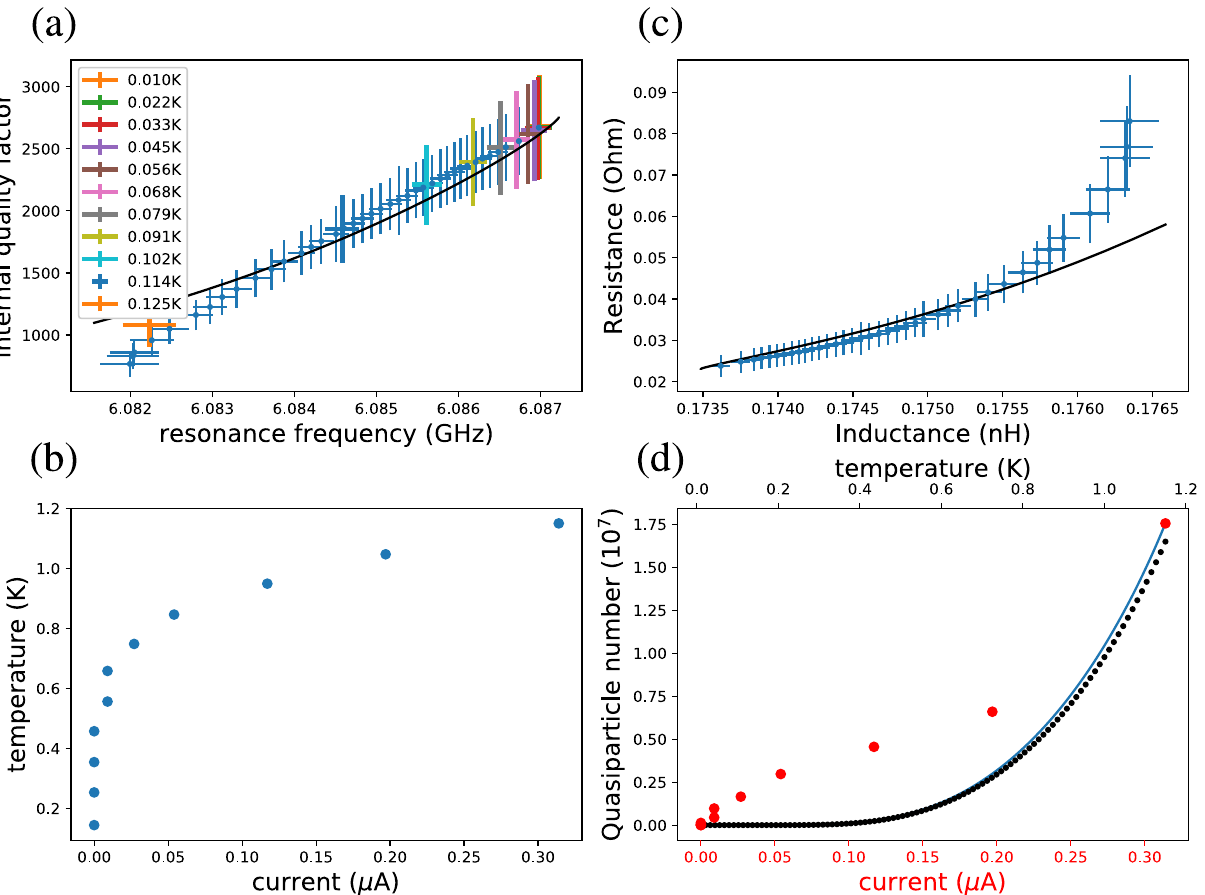
Figure 4. (a) Internal quality factor and resonance frequency of the resonator at different values of the applied direct current (blue markers), from 0 A (highest values) to 0.35 μA (lowest values), and at different cryostat temperatures as indicated by the colors. The black solid line is obtained from the Mattis–Bardeen theory as described in “Methods”. ( b ) Temperature of the resonator as a function of the applied current. We find these data points by matching the the data for different bias currents in ( a ) with those recorded at different temperatures. (c) Effective inductance and resistance of the aluminium strip (markers) according to the lumped-element model at different perturbation currents, from the unperturbed state (bottom left) to the 0.35 μA perturbation (top right). The data has been extracted from ( a ) considering a constant effective impedance contribution of 1.5 nH and a negligible effective resistance for the bare resonator. The solid line provides the corresponding values from the results of the Mattis–Bardeen theory in ( a ). (d) Number of quasiparticles in the aluminum strip as a function of the temperature (top horizontal axis) and bias current (bottom horizontal axis). The blue solid line considers the temperature dependence (top horizontal axis) from the integral in Eq. (5) and the black dots correspond to the approximation provided at the end of Eq. (5). The red points show the number of quasiparticles as a function of the bias current (bottom horizontal axis) according to the integral form of Eq. (5) where the temperature at a given bias current is obtained from panel ( b